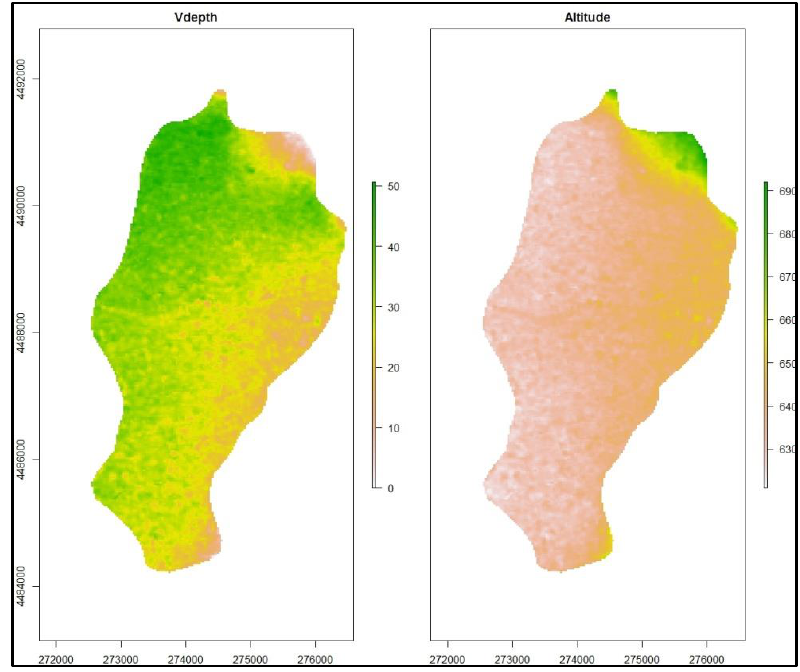
Figure 2. Topographic covariates of the study area. The maps of the satellite covariates that were used in the study (NDVI_2016,